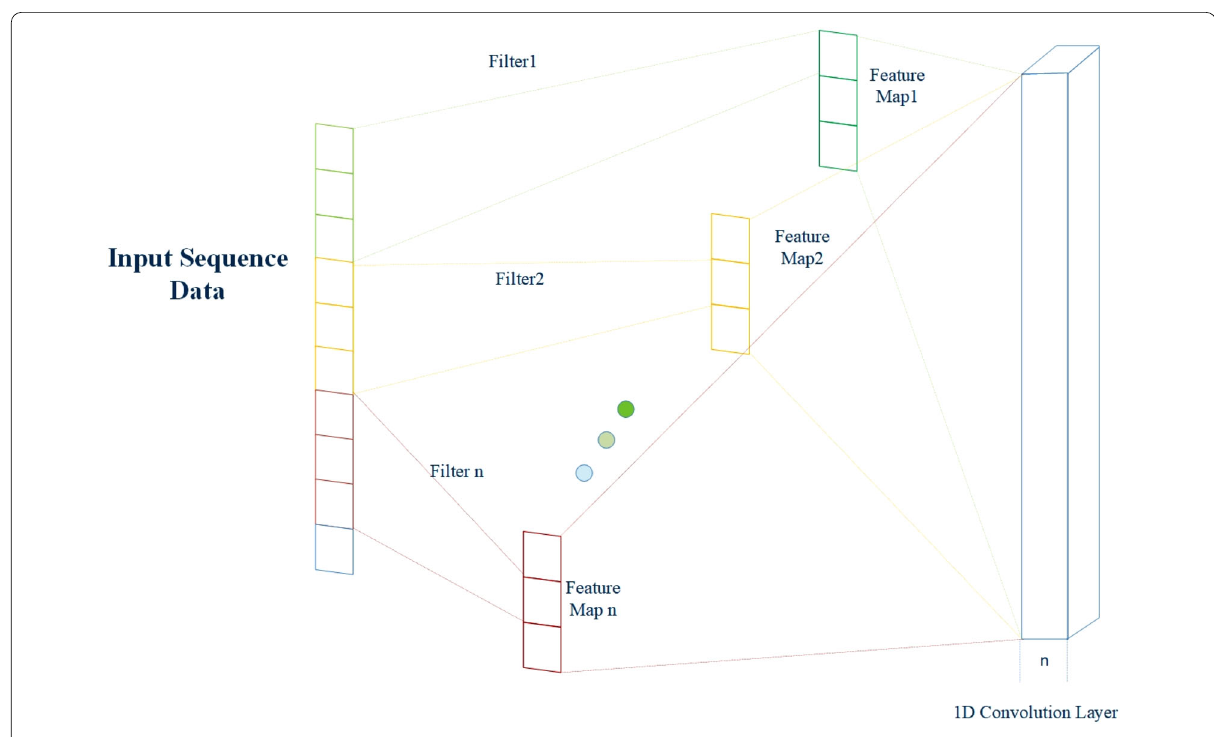
Figure 3 Illustration for 1D CNN